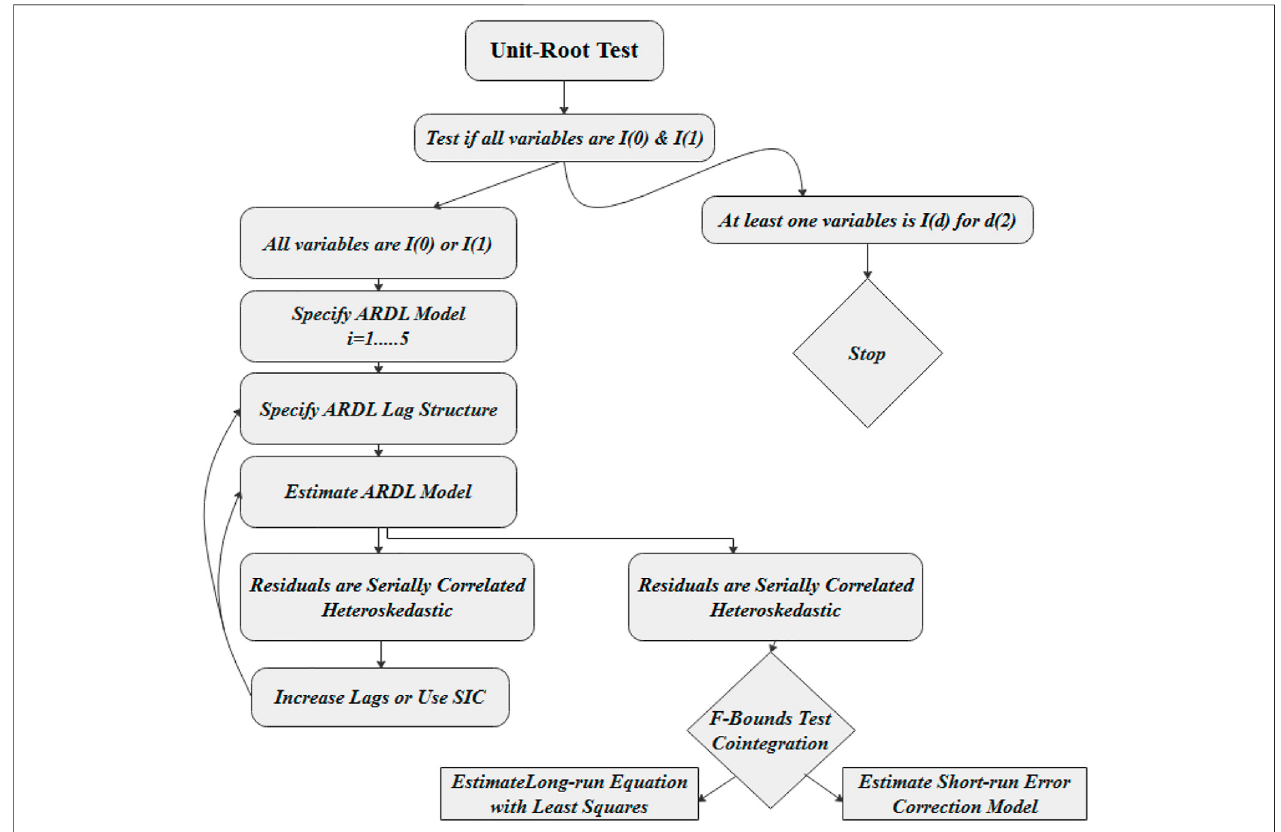
FIGURE 2 | Flowchart of the econometric